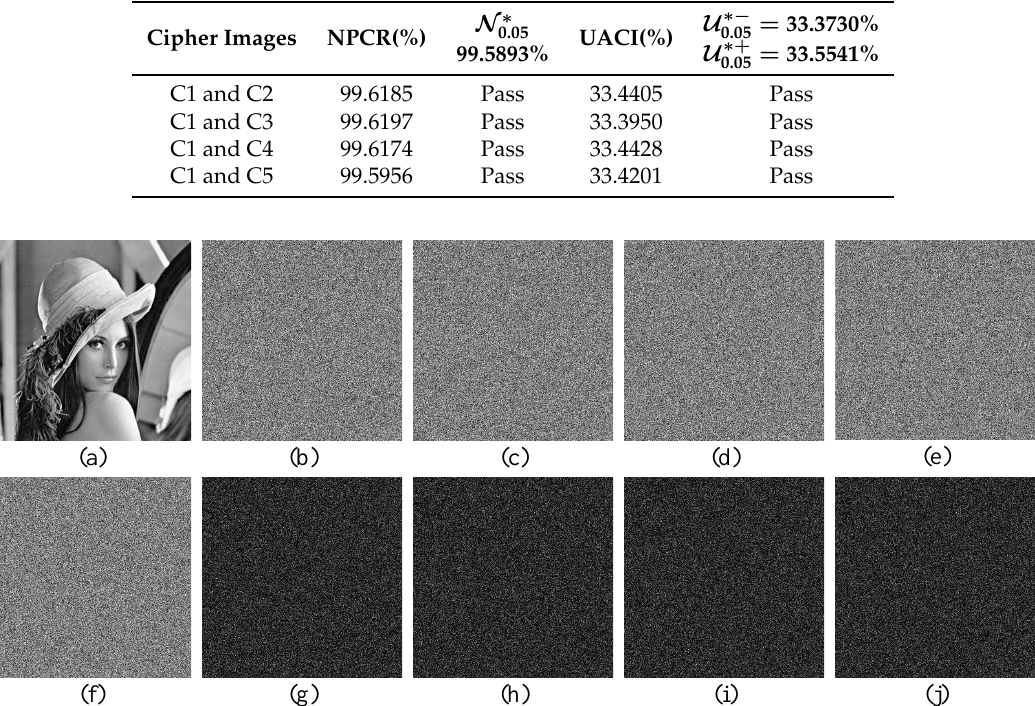
Figure 7. Key sensitivity. ( a ) Plain image of ’Lena’; ( b – f ) C 1, C 2, C 3, C 4 and C 5, respectively; ( g ) | C 1 − C 2 | ; ( h ) | C 1 − C 3 | ; ( i ) | C 1 − C 4 | ; ( j ) | C 1 − C 5 |